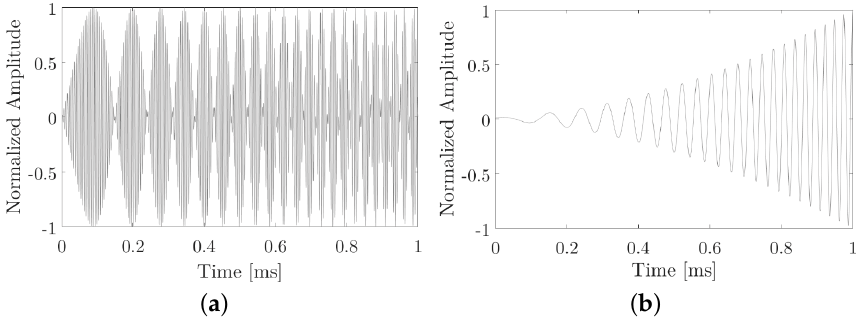
Figure 3. Bit 1 example. ( a ) sine-sweep modulation. ( b ) Parametric signals expected when sending sine-sweep modulation.